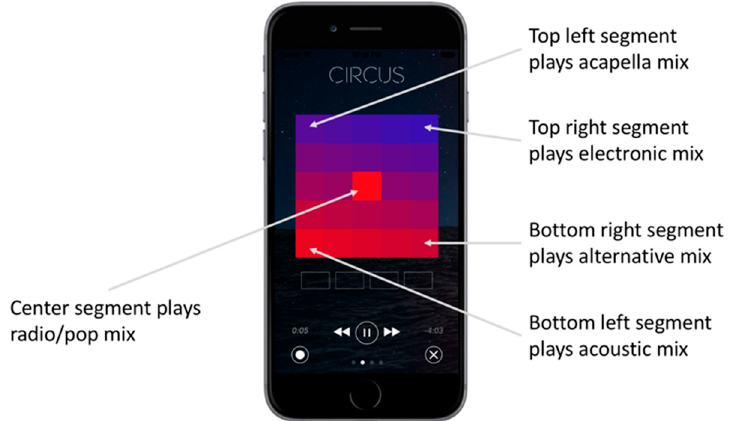
Figure 4. Matrix mixer for Circus by Daisy and The Dark. Multiple versions and curated mixes of each song are positioned within each segment of a 5 × 5 matrix.